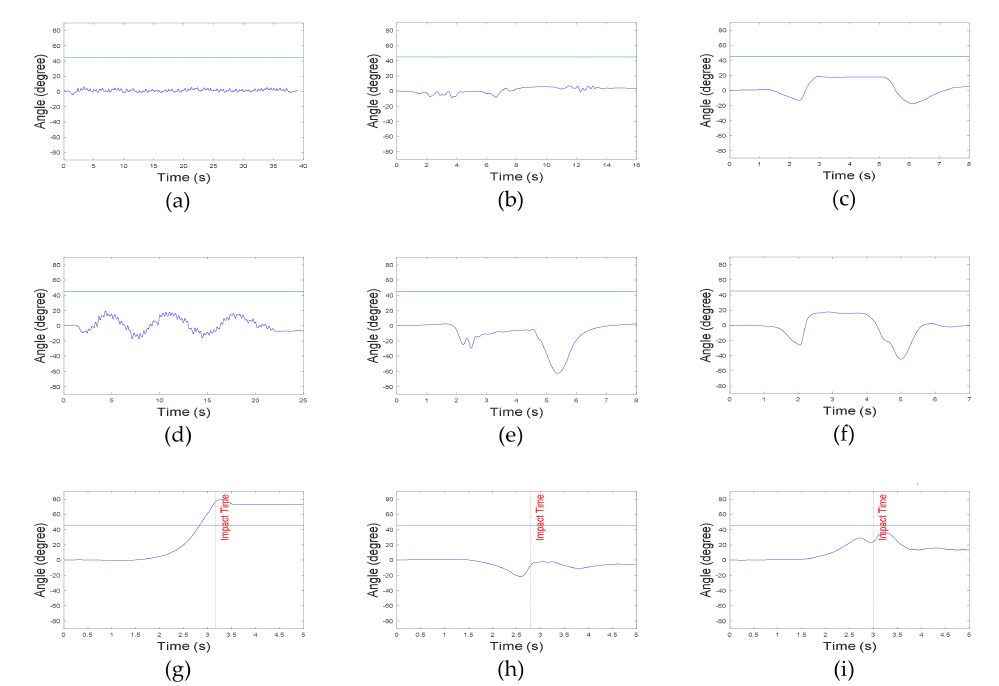
Figure 7. Pitch angle graphs. Less-dynamic motions: ( a ) walking, ( b ) climbing up and down the stairs, and ( c ) slowly sitting on the stool and getting up. Highly dynamic motions: ( d ) jogging, ( e ) quickly sitting on the chair and getting up, and ( f ) quickly sitting on low-height mattress and getting up. Fall motions: ( g ) backward fall, ( h ) lateral fall, and ( i ) twist fall.